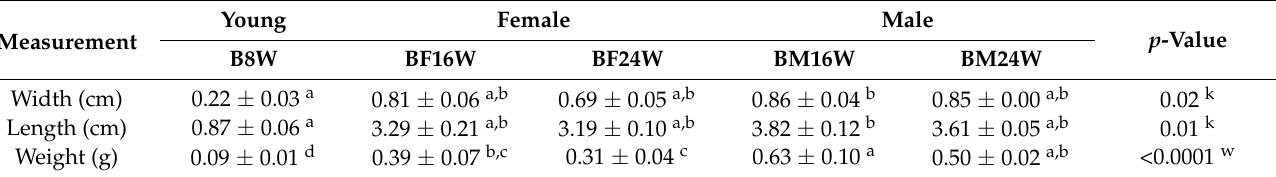
Table 1. Basic characteristics of Siamese fighting fish used in this